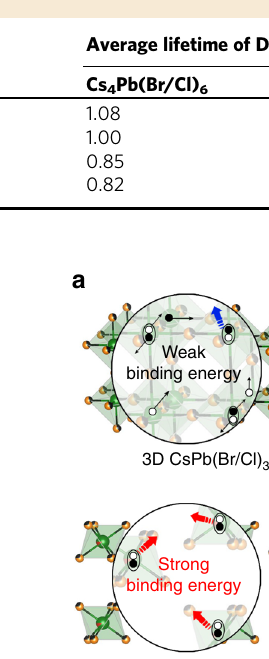
Table 3 Average lifetime of D-state emission of Cs 4 Pb(Br/ Cl) 6 and Cs 4 PbCl 6 monitored at 420 nm and 400 nm, respectively